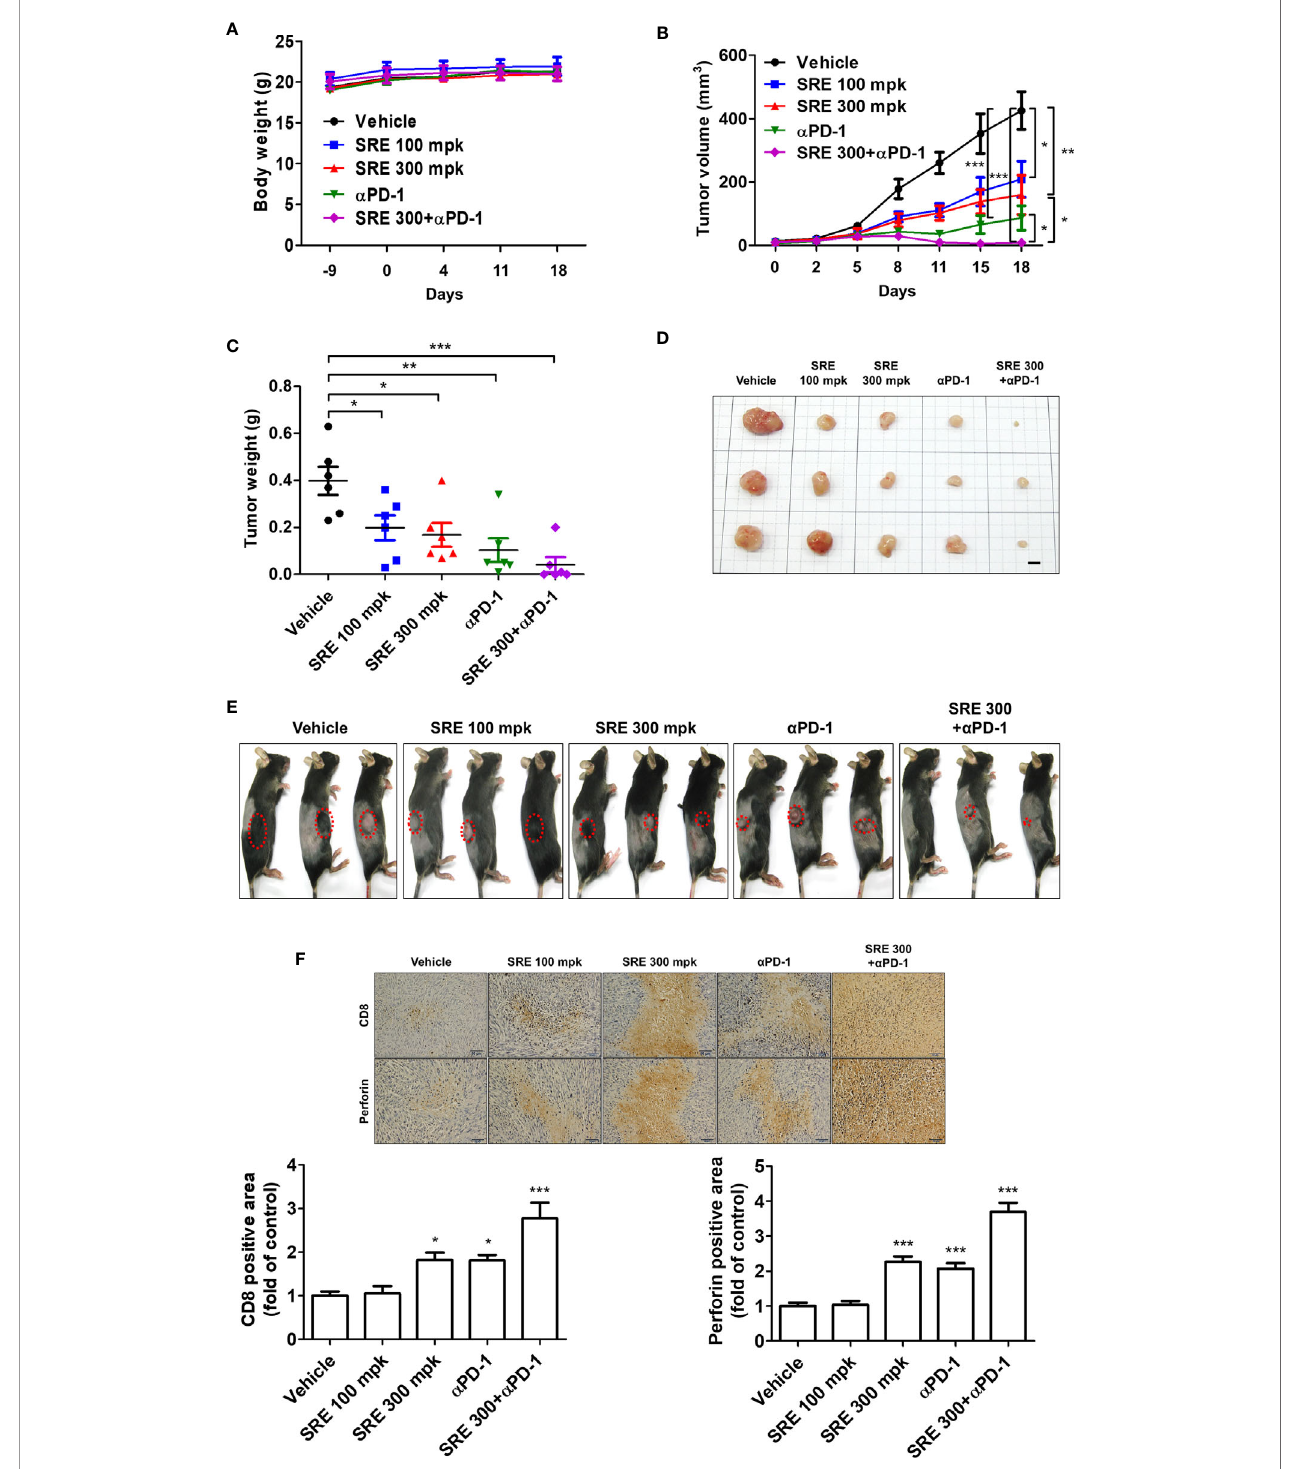
FIGURE 5 | Sanguisorbae Radix extract reduced tumor growth in the hPD-L1 MC38 cell allograft hPD-1 mouse model. (A) Body weight (grams); (B) Tumor volume after 18 days; (C) Tumor weight after 18 days; (D) Images of tumor tissues (bar indicates 5 mm); (E) hPD-L1 MC38 tumor-bearing mice 18 days after treatment; (F) Representative microscopic images (×400) of CD8 and PRF1-positive area of tumor tissues calculated using immunohistochemical analysis. Data are presented as mean ± standard deviation. * p < 0.05, ** p < 0.01, and *** p < 0.001 compared with the vehicle